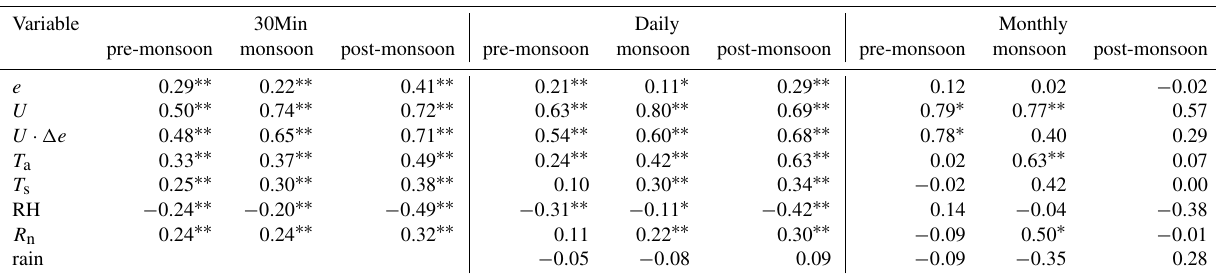
Table 3. The Pearson correlation coefficients between 30Min, Daily and Monthly latent heat flux (LE) and vapor pressure difference ( e ) between water surface ( e s ) and the air ( e a ), wind speed ( U ), the product of wind speed and vapor pressure difference ( e ) between water surface and the air ( U · (cid:49)e ), air temperature ( T a ), water surface temperature ( T s ), relative humidity (RH), net radiation ( R n ), and rain, during pre-monsoon, monsoon and post-monsoon periods for the whole study period (2012 to 2015). The significant levels of 0.01 and 0.05 are marked with ∗∗ and ∗ , respectively. The correlation coefficients between rain and LE are estimated only at daily and monthly timescales. Variable 30Min